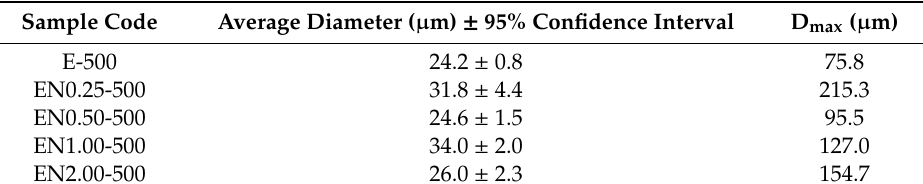
Table 5. E ff ect of CNT content on average and maximum microcapsule diameters.